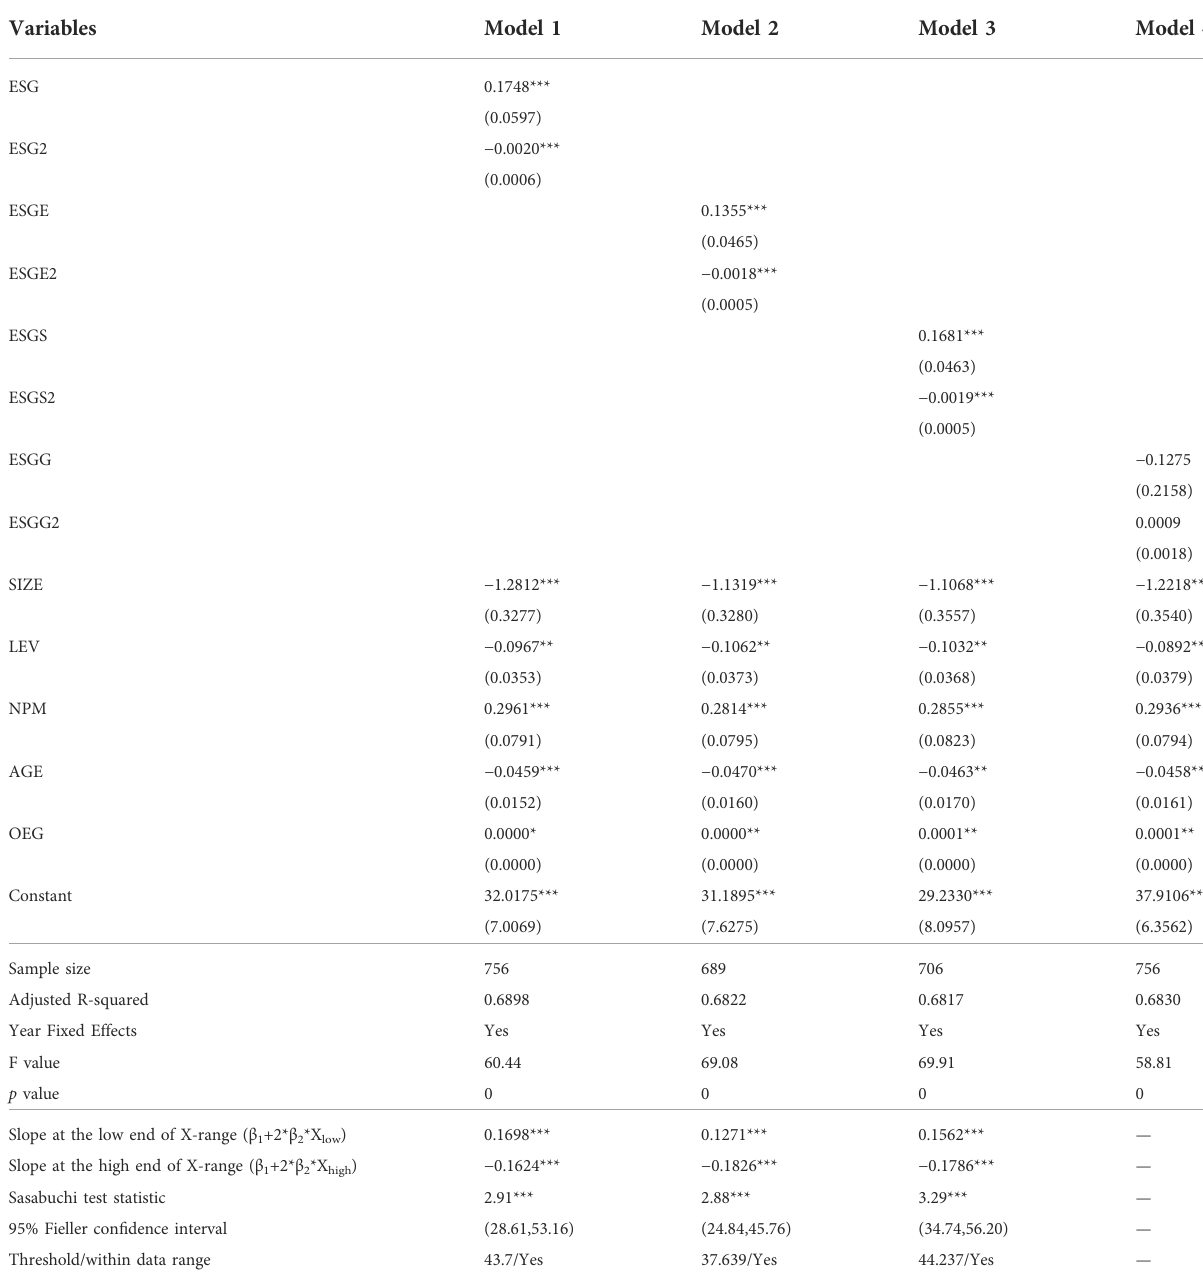
TABLE 3 Baseline nonlinear model using